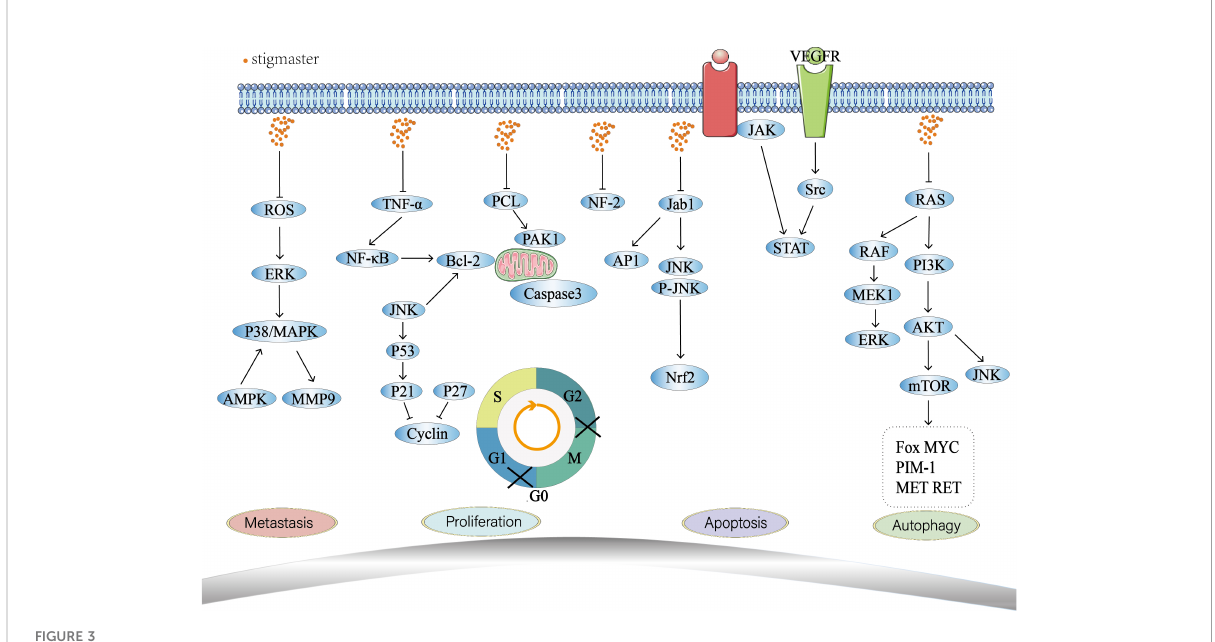
FIGURE 3 Antitumor mechanisms of